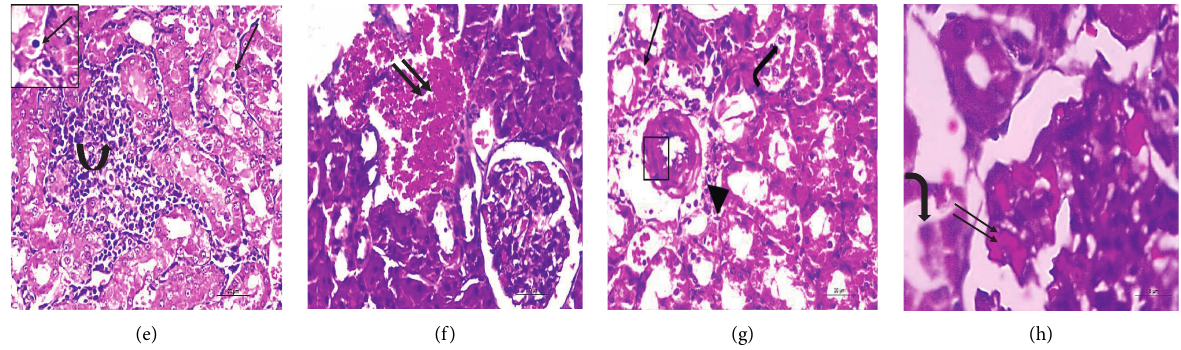
Figure 3: Representative micrographs of H&E-stained renal sections of the sedentary aged group ( N � 10) revealing marked degenerative changes. Some glomeruli are shrunken (Sh) with a widening of Bowman’s space (w); others show obliteration of their Bowman’s space (thick arrow). Congested glomerular capillaries (double thin arrows) are also noted. Most renal tubules exhibiting cytoplasmic vacuolation (v), pyknotic nuclei (thin arrows), exfoliating cells (bent arrows), and marked tubular dilatation (star). The renal interstitium showing intense hemorrhage (double thick arrows) and marked inflammatory infiltrate (arched arrow). Thick-walled blood vessels (rectangle) with perivascular inflammatory infiltrate (arrowhead) are also noted. H&E (a–g): 40x, scale bar � 20 µ m; (h): 100x, scale bar � 8 µ m. N � number of rats.